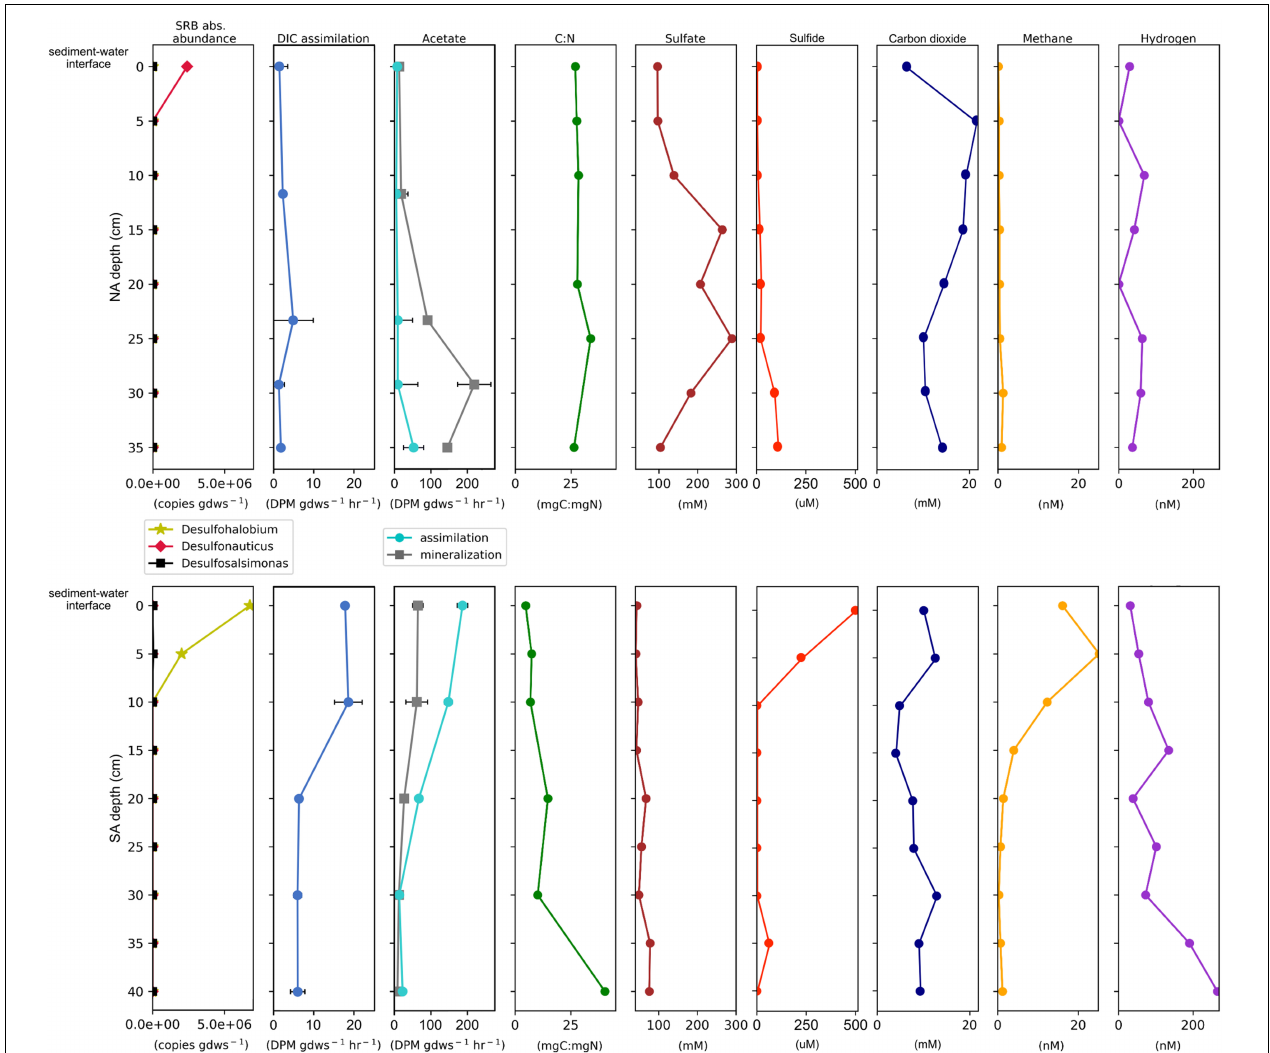
FIGURE 5 | Select geochemical measurements juxtaposed with rate potentials of biological CO 2 assimilation and acetate transformation and the abundances of sulfate reducing bacteria (SRB) plotted by depth for the North Arm (NA, top) and South Arm (SA, bottom). Not shown are measured pH values, which were 8.3 ± 0.2 throughout the NA core and 7.9 ± 0.1 throughout the SA core (see Supplementary Table S7 ). Standard error for gene copy number measurements can be found in Supplementary Table S9 . Abbreviations: GDWS: gram dry-weight sediment. DIC: dissolved inorganic carbon. DPM: disintegrations per minute. C:N: total organic carbon: total nitrogen